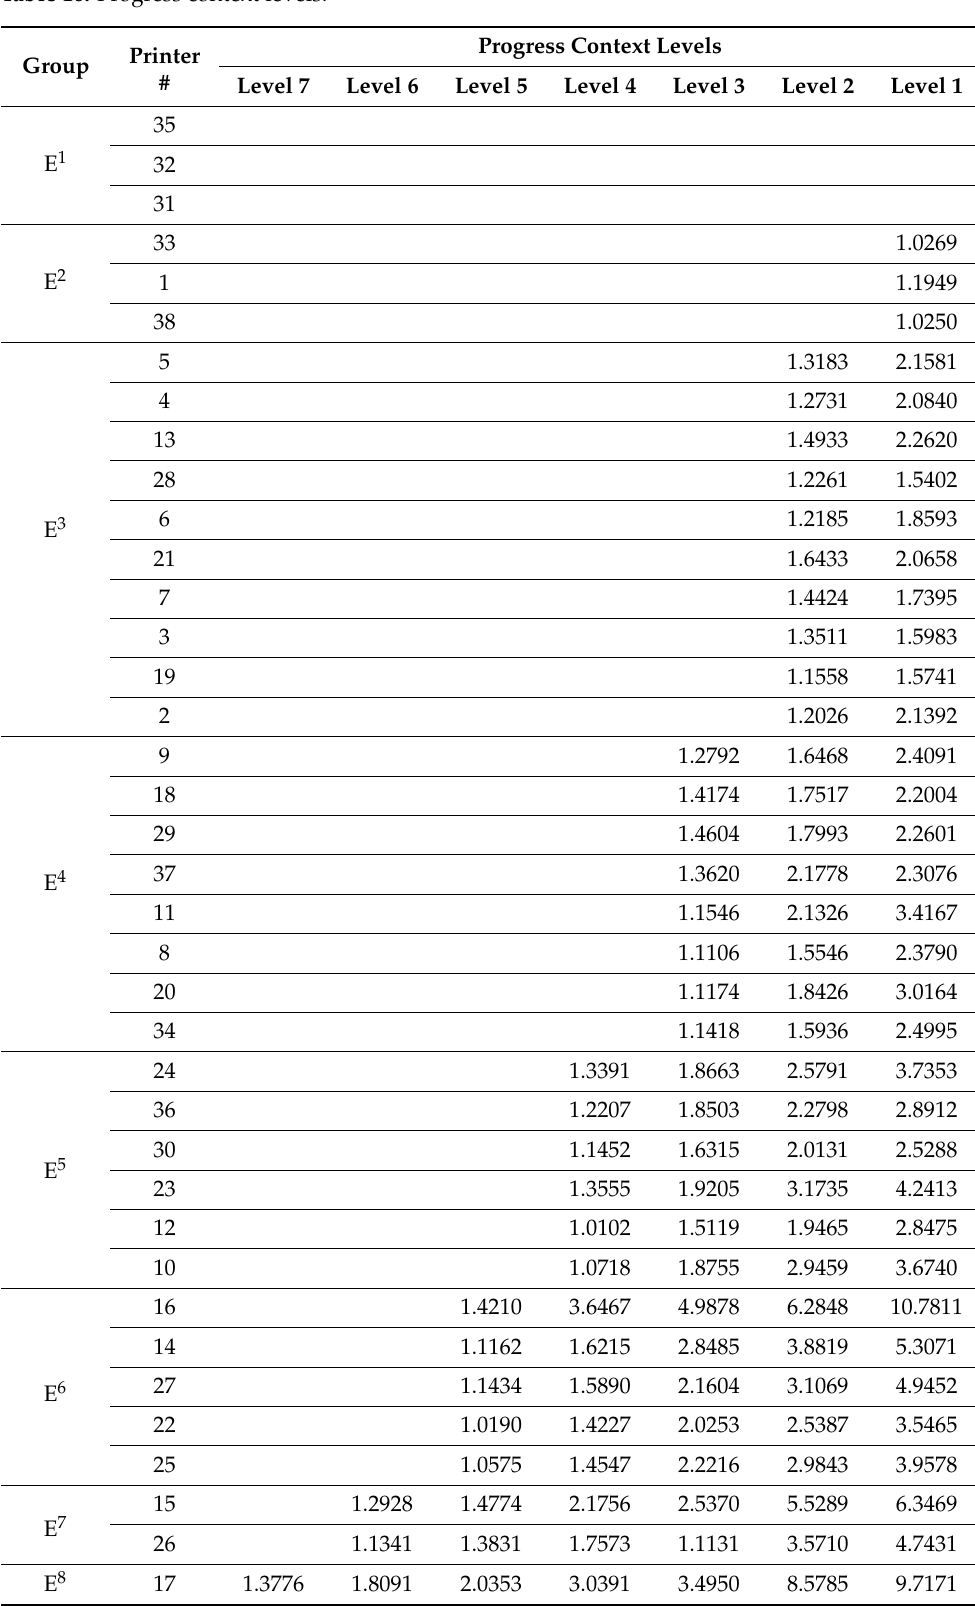
Table 10. Progress context